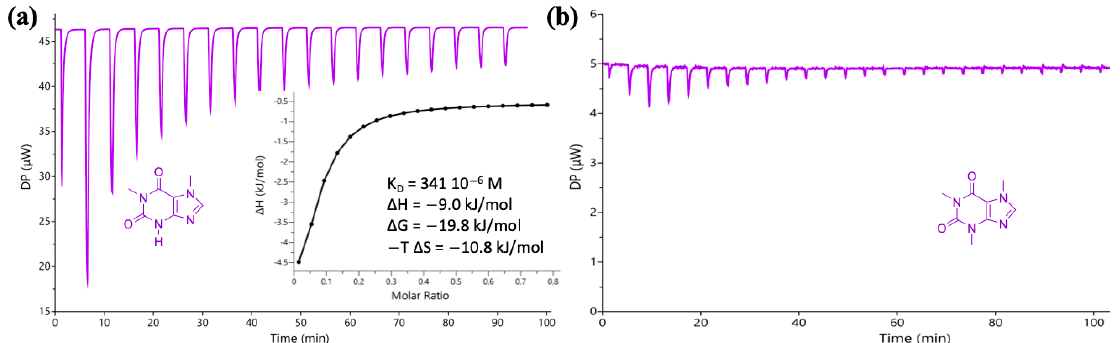
Figure 4. ( a ) Raw ITC data for the stepwise injection of imidazole (IM; 20 mM) into a solution of paraxanthine (5.6 mM), at 25 ◦ C. Inset: integrated heat plot (enthalpogram). One site-specific binding model was employed to fit the hyperbola and obtain the K diss (341 × 10 − 6 M). ( b ) Raw ITC data for the stepwise injection of IM (20 mM) into a solution of caffeine (5.6 mM), at 25 ◦ C. All solutions were prepared in